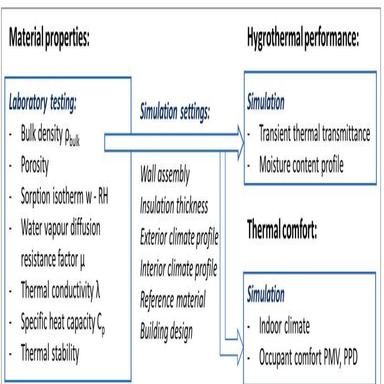
Methodology overview.